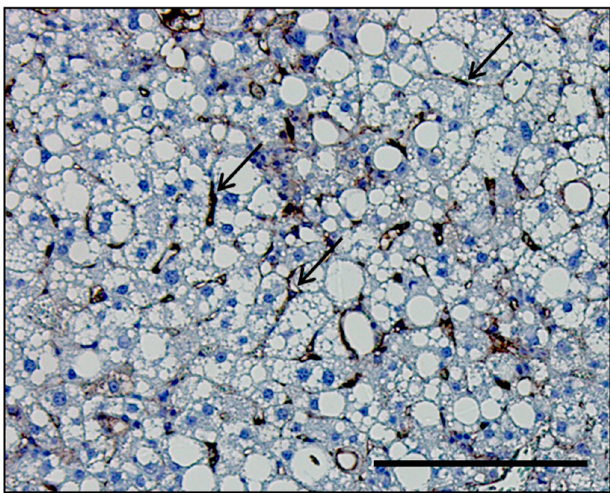
Figure 1. Histological section of the liver of a mouse with nonalcoholic steatohepatitis (NASH). Representative histological section of the liver of a mouse with diet-induced NASH immunostained with the adhesion molecule vascular cell adhesion molecule 1 (VCAM-1), which is predominantly upregulated in LSEC in NASH. VCAM-1 stain delineates LSEC (black arrows) in relation to hepatocytes. Scale bar, 100 μ m.